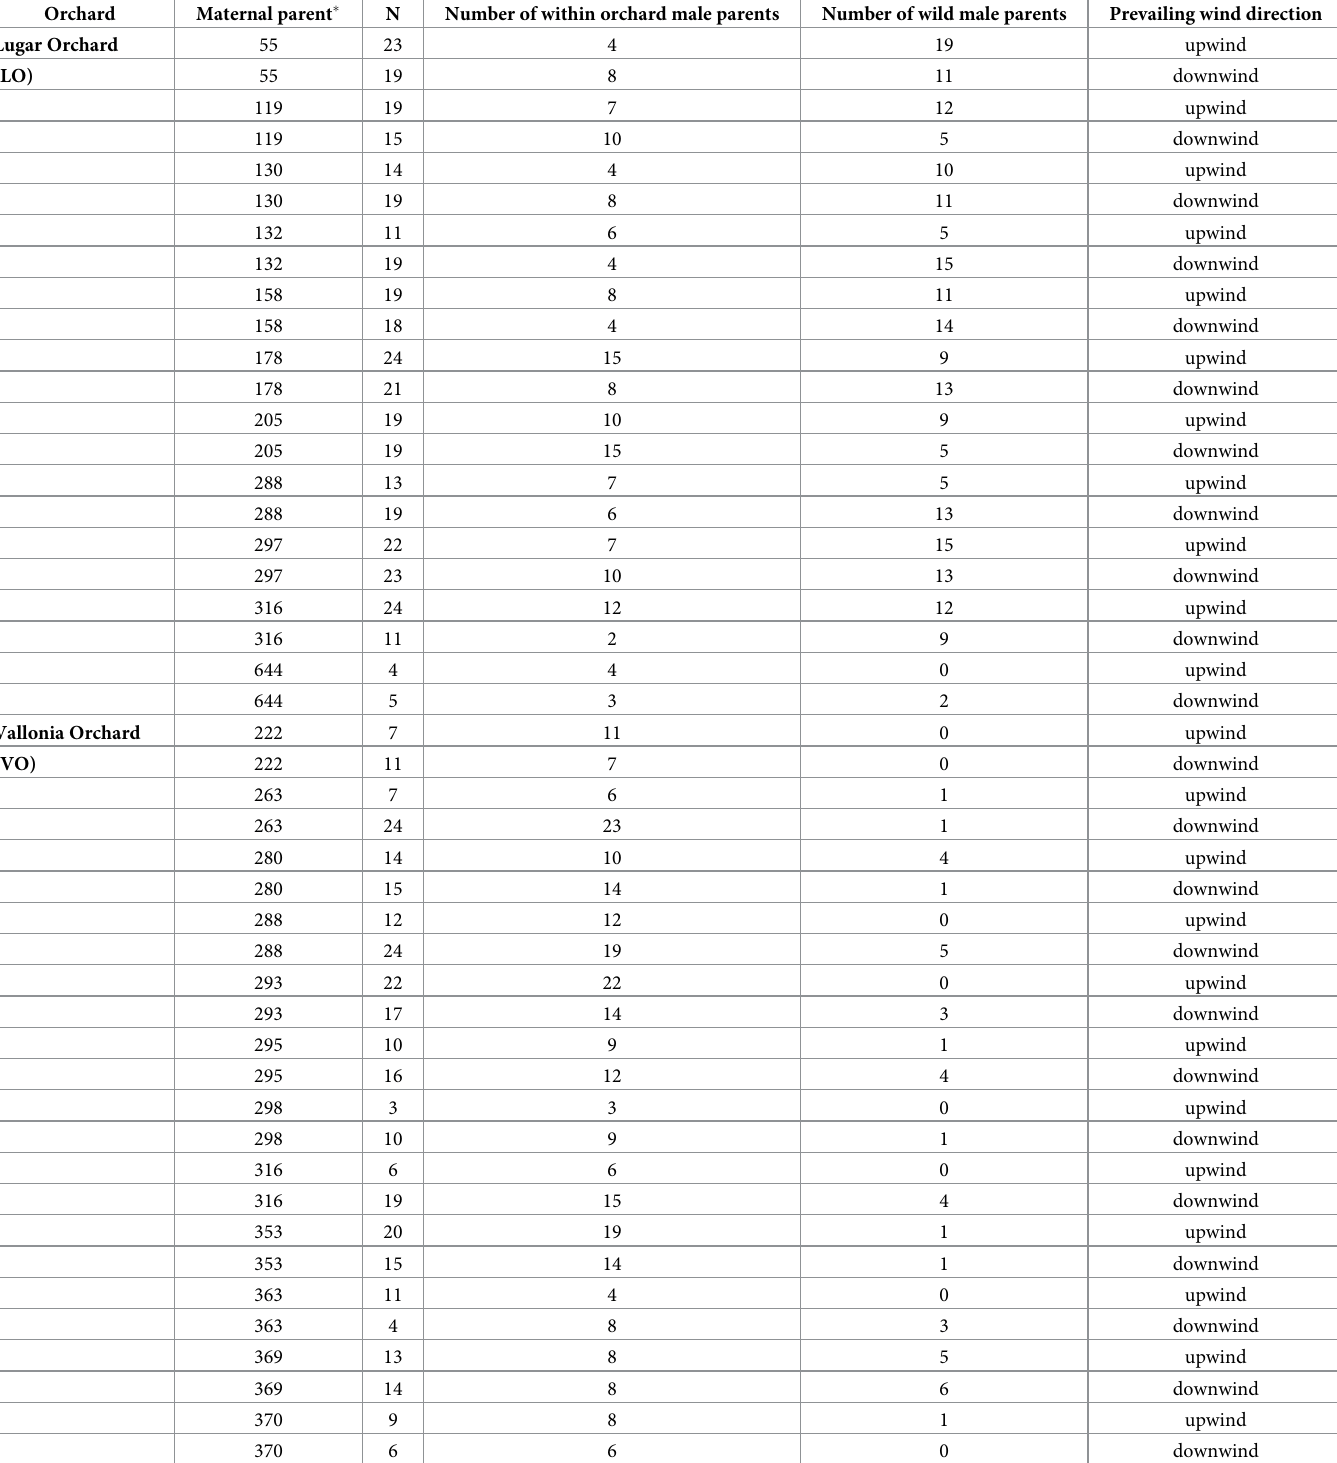
Table 1. Number of seedling progeny per orchard clone and prevailing wind direction.